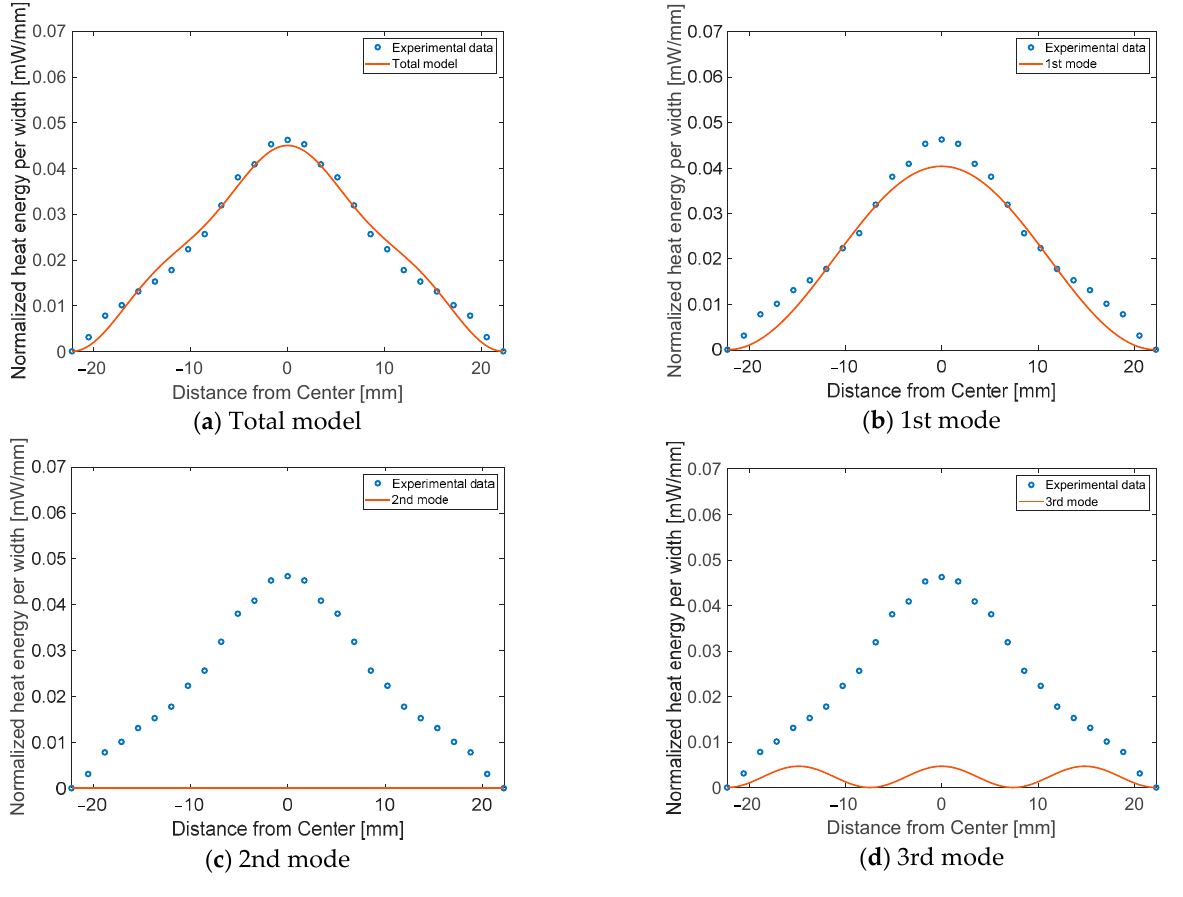
Figure 12. Effect of each eigenmode on the energy distribution: ( a ) Total model; ( b ) 1st mode; ( c ) 2nd mode; ( d ) 3rd mode.